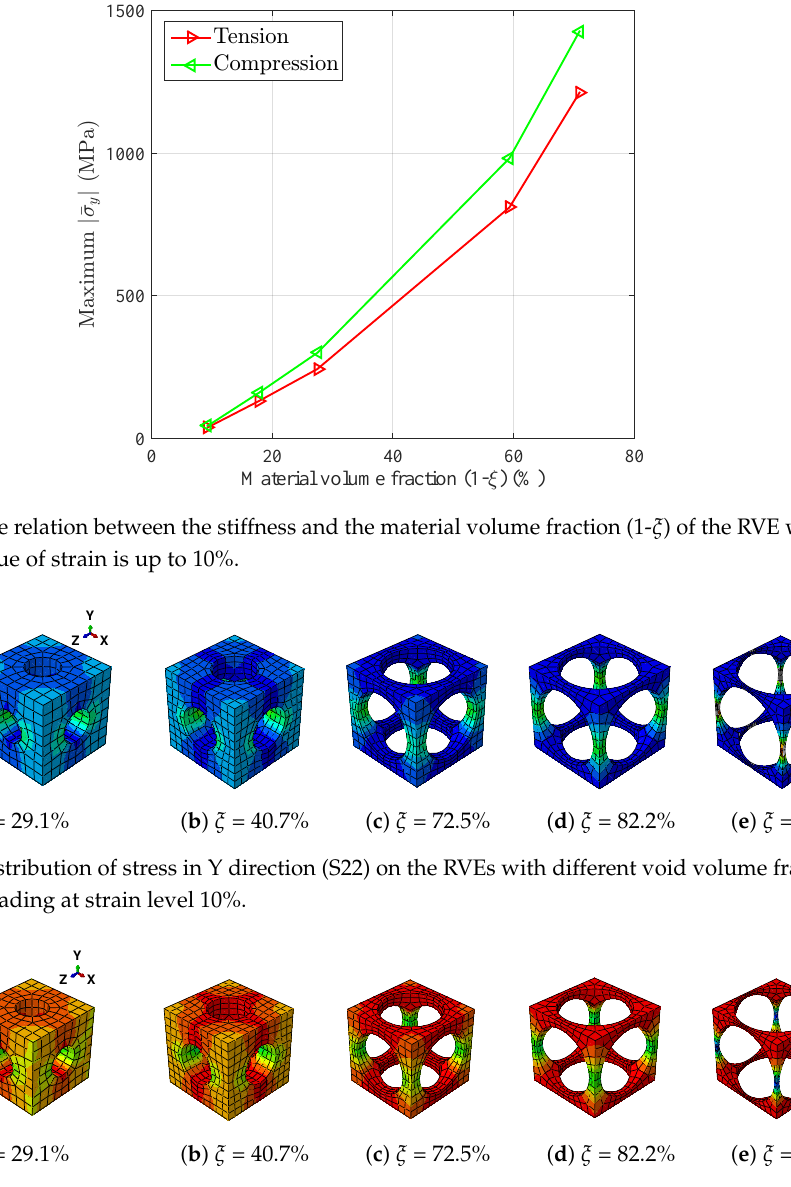
Figure 7. Distribution of stress in Y direction (S22) on the RVEs with different void volume fractions ξ in compression loading at strain level −